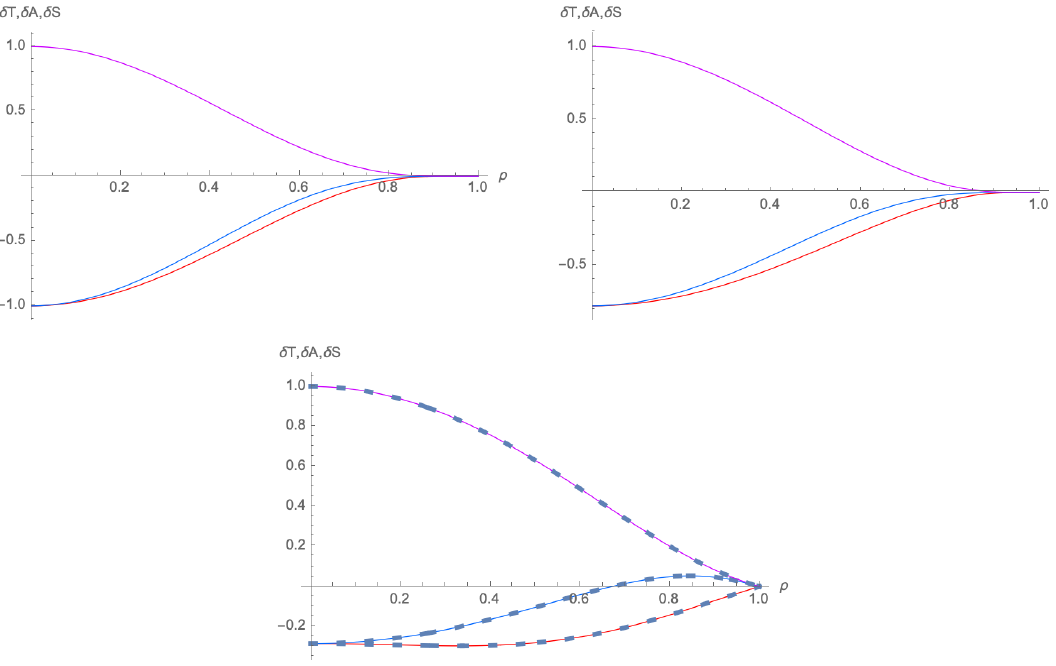
Figure 2 . The numerically generated wavefunctions, δT (Red), δA (Blue) and δS (Purple) for the unstable mode are plotted against the radial coordinate ρ for the unstable mode for r − = 0 (top left), r − = 1 / 6 (top right) and r − = 1 / 3 (bottom). The instability becomes a static perturbation for r − = 1 / 3 , which corresponds to a perturbation within the RN family, and may be computed independently. This is compared by means of dashed curves in the bottom plot, the agreement providing a check of our numerically constructed